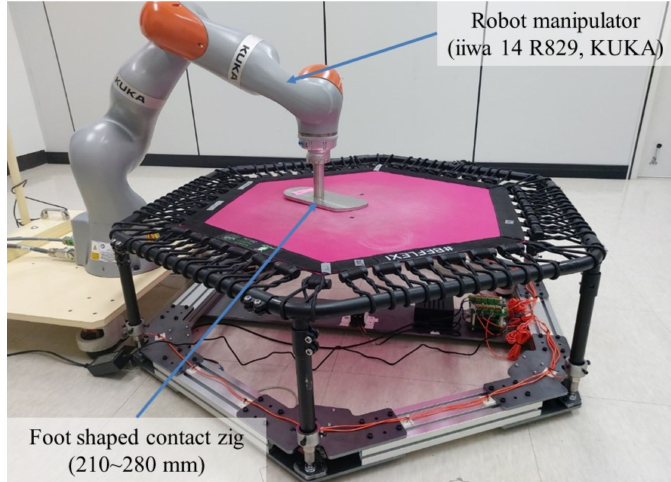
Figure 2. Experimental environment for collecting the learning and test